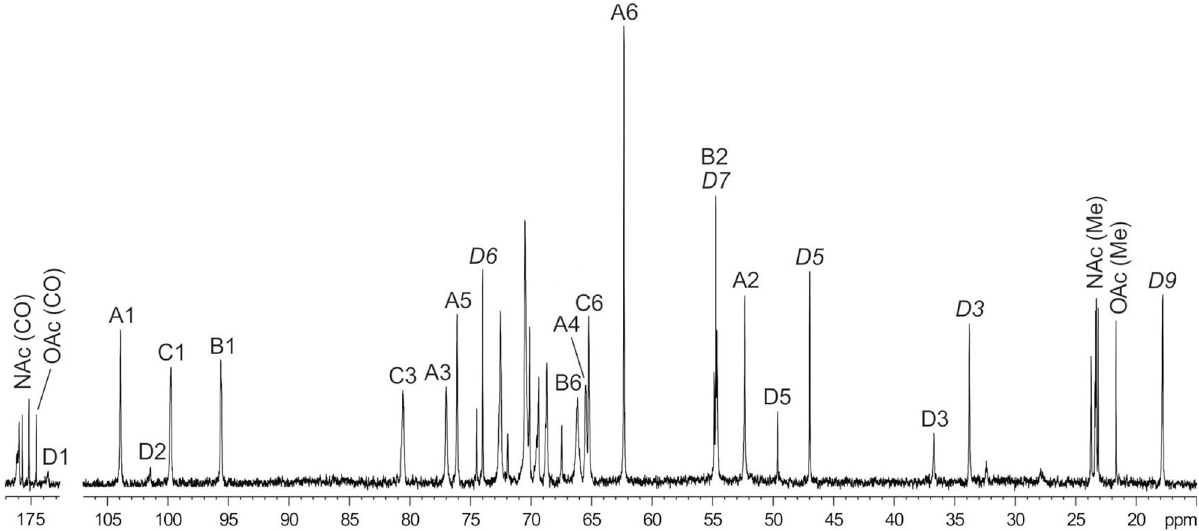
Fig 3. 13 C NMR spectrum of the capsular polysaccharide CPS K46 from A . baumannii NIPH 329. Numbers refer to carbons in sugar residues denoted by letters as shown in Table 1. Signals of Pse4Ac5Ac7Ac are annotated in italics.